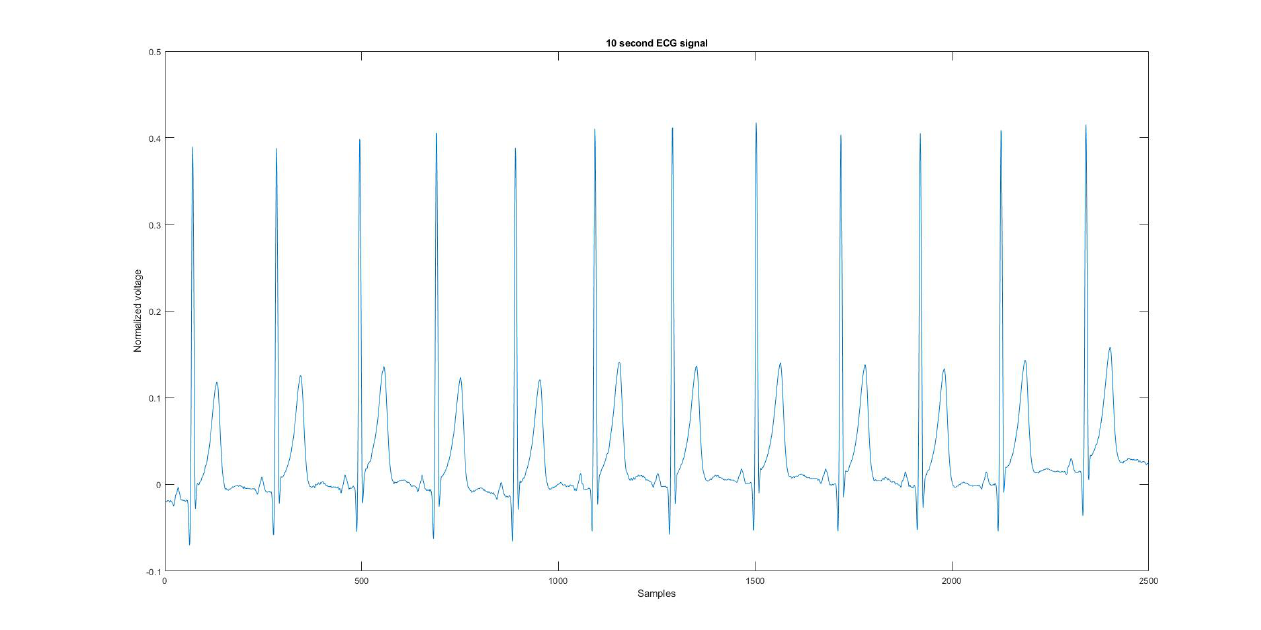
Figure 4. The reference signal from Astroskin smart